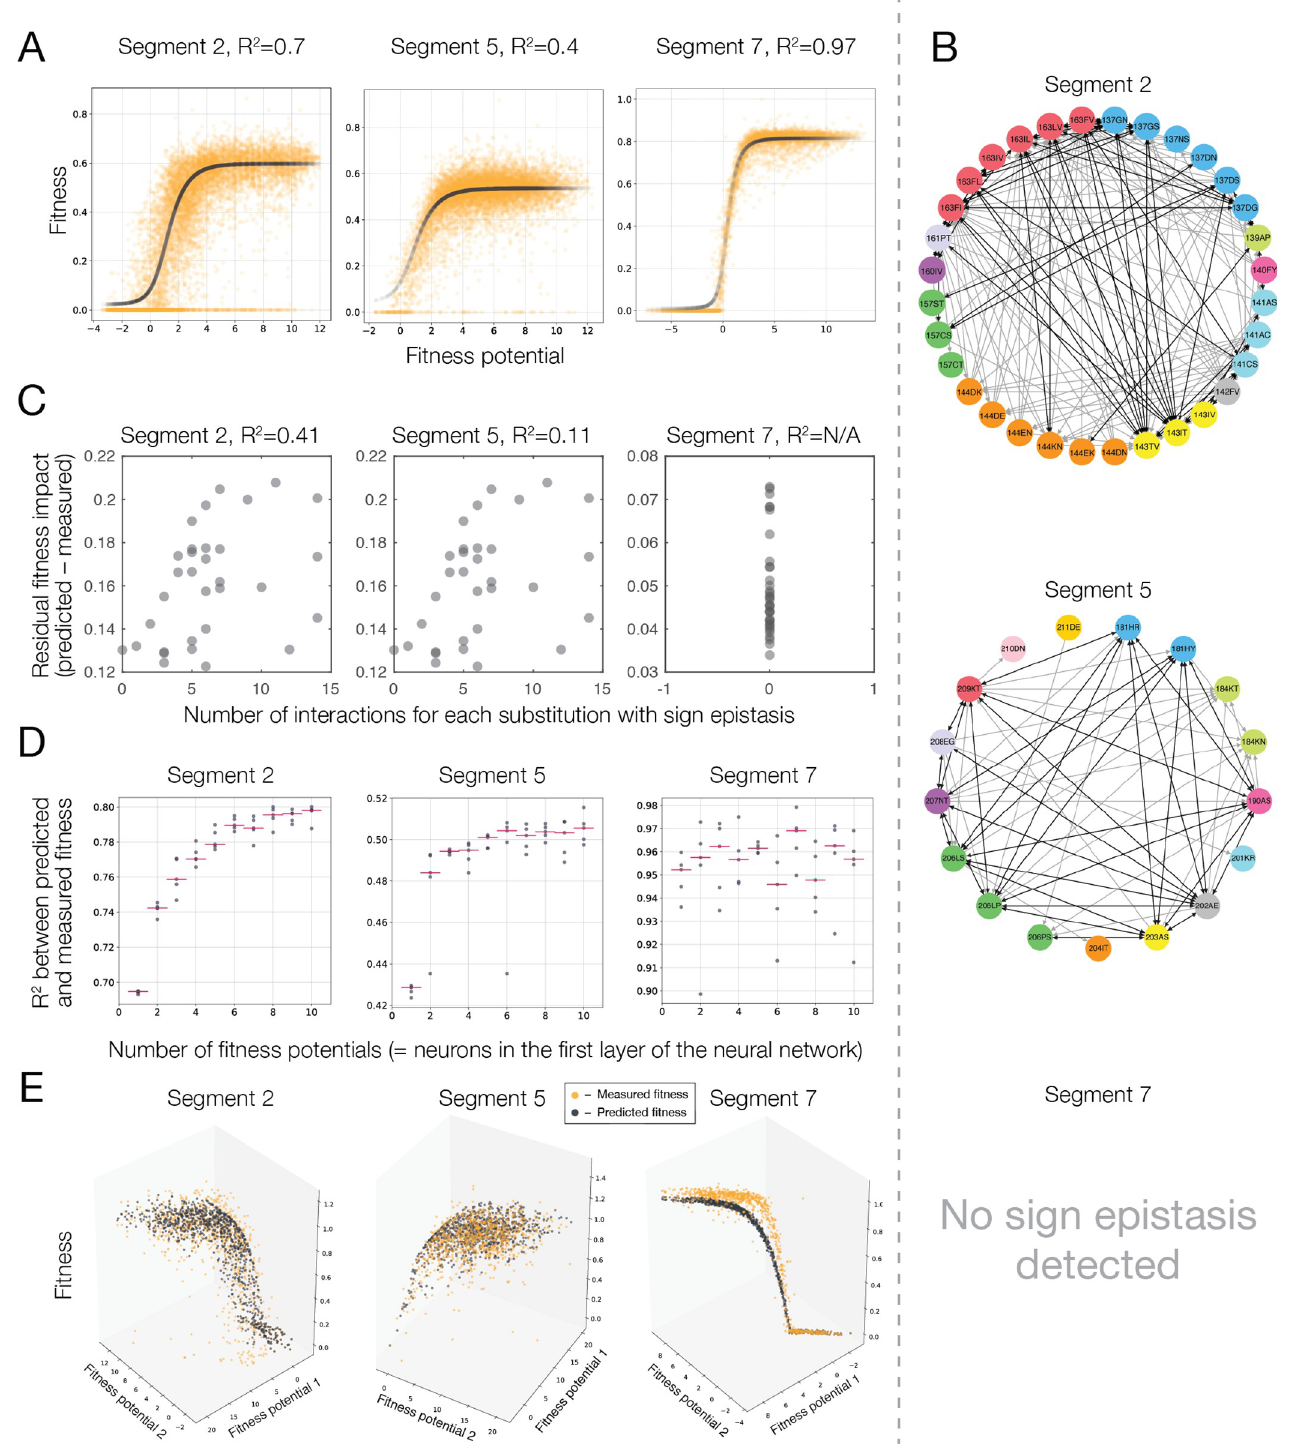
Fig 5. Epistasis and the His3 fitness landscape for segments 2, 5 and 7. a, Fitness as a function of a single fitness potential (black curve, the fitness of individual genotypes is orange). b, A network depiction of sign epistasis between amino acid replacements. Colour coded sites with reciprocal sign epistasis (black lines) and unidirectional interactions (grey arrows) are shown. c, Genotypes containing replacements with a higher number of sign epistatic interactions are less likely to be fit by the threshold function of the fitness potential. d, Increasing the number of neurons in the first layers of the neural network, which is equivalent to increasing the number of underlying fitness potentials, leads to more accurate models for segments with detected sign epistasis. Each dot